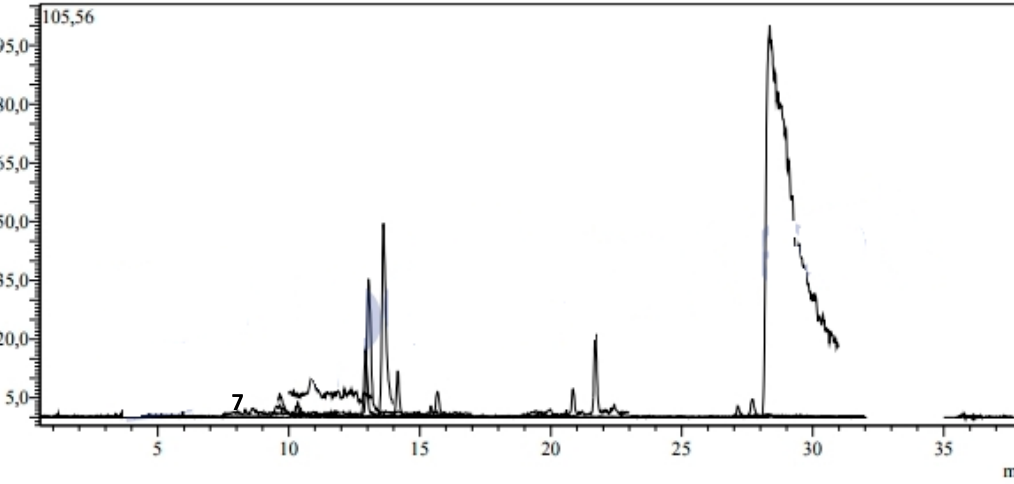
/ MS chromatogram of DCM extract of H. laevigata var. hipponensis Figure 5. LC-MS/MS chromatogram of DCM extract of H. laevigata var. hipponensis. Figure 5. LC-MS